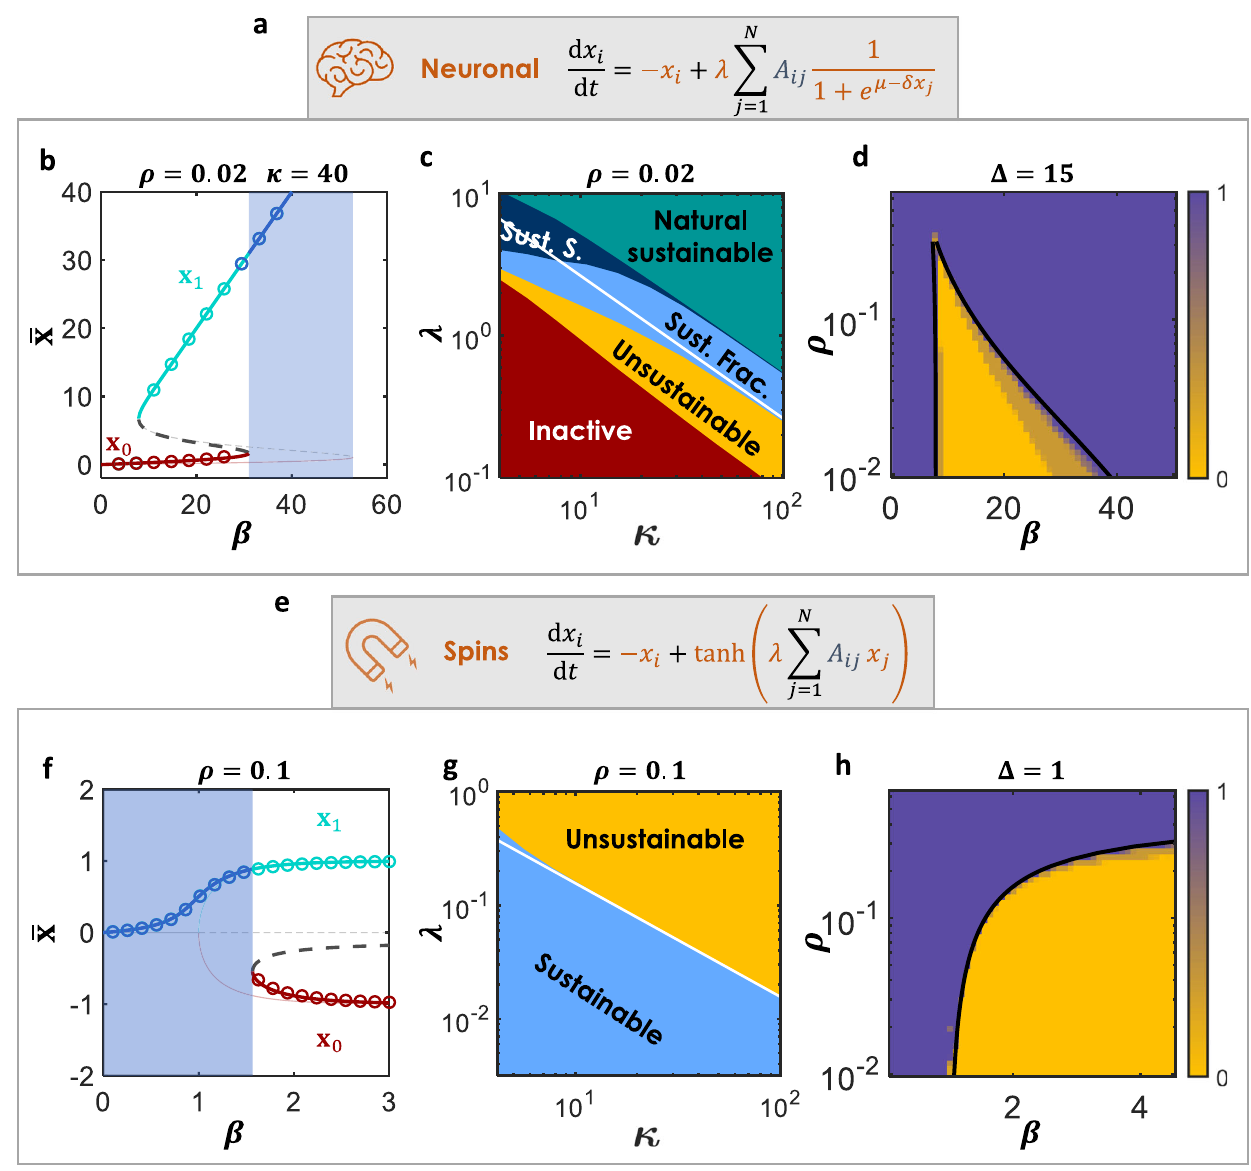
Fig. 5 Sustaining neuronal and spin dynamics. a Neuronal dynamics based on Wilson – Cowan model 52,53 . b Phase diagram for dynamics of the forced system via fraction ρ = 0.02 and holding value Δ = 15 according to Eq. (8). The network is Erd ő s-Rényi (ER) with N = 10 4 and κ = 40. The forced curve is shifted left relative to the free system curve (thin and light lines), yielding a window of sustaining (blue shade) ( c ) ( κ , λ )-space shows a sustaining phase diagram containing fi ve phases. Our theory, Eqs. (8) and (11), predicts for high degrees well the transition between unsustainable and sustainable by fraction ρ = 0.02 and Δ = 15 (the white line). The light blue area is the sustainable phase for controlling a fraction ρ = 0.02, and the dark blue phase is the sustainable region when controlling a single node. d ( β , ρ ) phase diagram for κ = 20, 60, 100. e Model for spin dynamics based on Ising-Glauber model 54 . f While the free system (light and thin lines) shows a diagram with a zero regime and bi-stable symmetric regime, the forced system (thick lines) exhibits two regions: for a dense network (large β ) coexistence of x 0 and x 1 , and for a sparse network (small β ) only x 1 appears. Consequently, there is a range of sustaining (blue shade). Here ρ = 0.1 and Δ = 1. The network is ER with N = 10 4 and κ = 40. g The ( κ , λ ) phase diagram for ρ = 0.1 and Δ = 1. Here there is no sustainable phase when holding a single node since controlling a single node does not change the global system states in this dynamics. The simulations were averaged over 10 realizations of ER networks with N = 10 4 . The white line represents the theory of Eq. (S4.41) in Supplementary Note 4 with Eq. (11). h The ( β , ρ ) phase diagram for fi xed Δ = 1. Color represents simulations on ER with κ = 20, 60, 100 and N = 10 4 . The results were averaged over ten realizations. The black line stands for the theory of Eq. (S4.41) in Supplementary Note 4 with Eq.